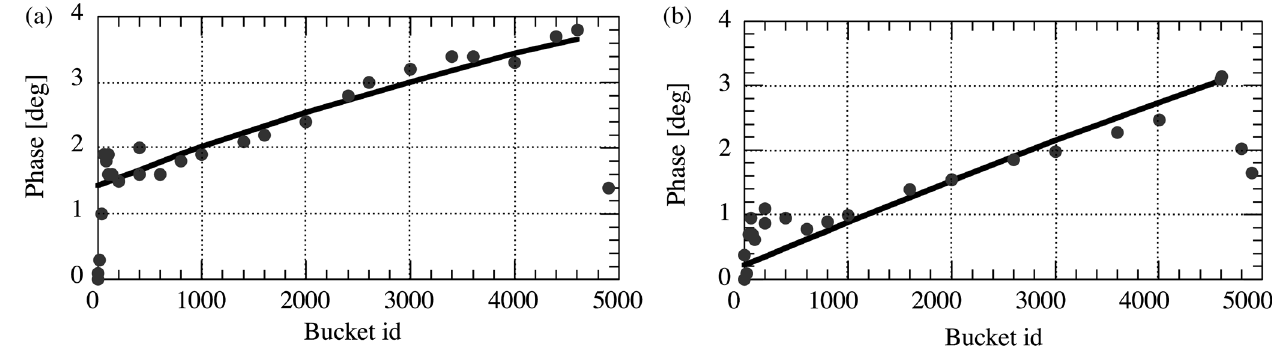
FIG. 2. Examples of the observed phase modulation caused by a bunch gap transient in KEKB operation. (a) LER with a beam current of 660 mA and (b) HER with 470 mA. The solid lines indicate the results of the simulation reported in Ref. [11], which used equivalent single-cell cavities operating in the accelerating